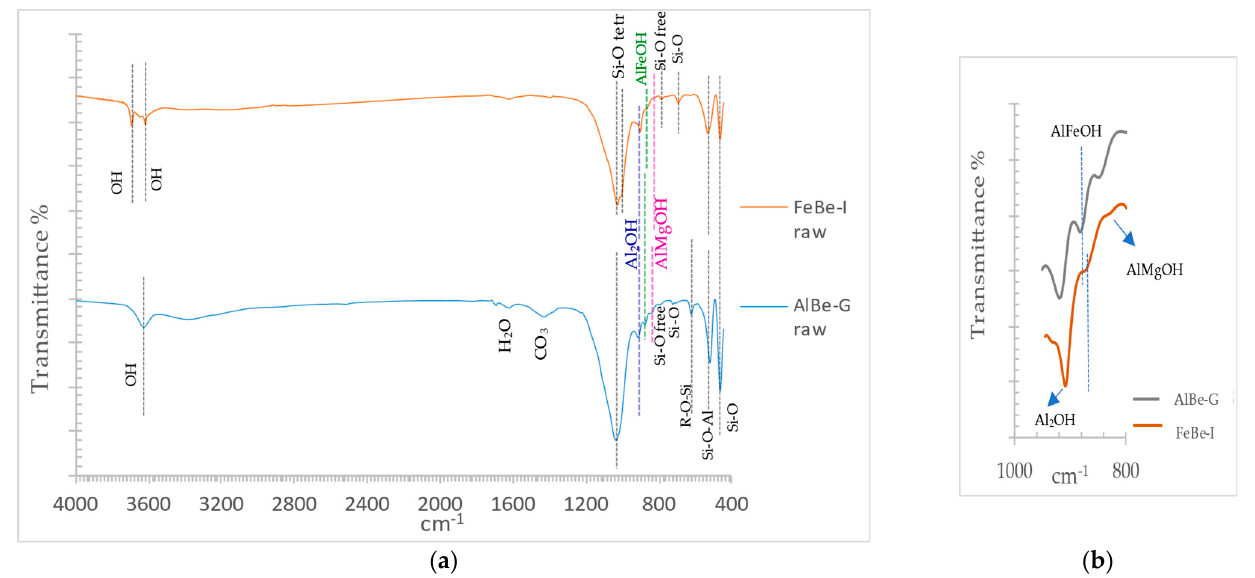
Figure 2. FT − IR spectra of raw materials. ( a ) Full spectra; ( b ) section 1000–800 cm − 1 . In the FeBe-I sample’s spectrum, the bands at 1030 cm − 1 and 1012 cm − 1 are as- signed to the Si-O stretching band [9]. As in the AlBe-G sample, the Si-O-Al and Si-O-Si bending vibration bands are observed at 535 cm − 1 and 468 cm − 1 , respectively, while the Al 2 OH, AlFeOH and AlMgOH peaks appear at 907, 874 and 832 cm − 1 , respectively. The bands at 3623 cm − 1 and 3696 cm − 1 are assigned to hydroxyl groups joined together with octahedral